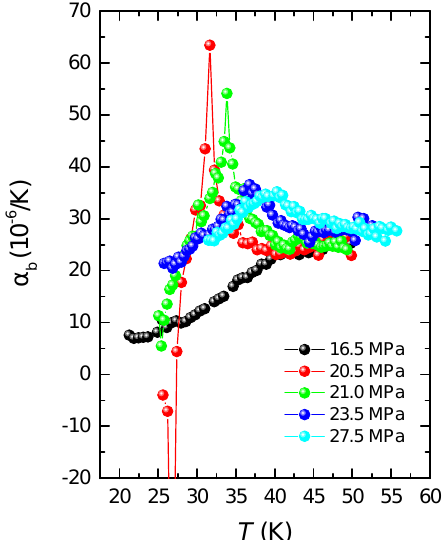
Figure 2. Thermal expansion coefficient along the out-of-plane b axis, α b , of κ -(BEDT-TTF) 2 Cu[N(CN) 2 ]Cl (batch #AF063) after exposure to X-ray for 50h as a function of temperature T at constant pressures 16.5MPa ≤ p ≤